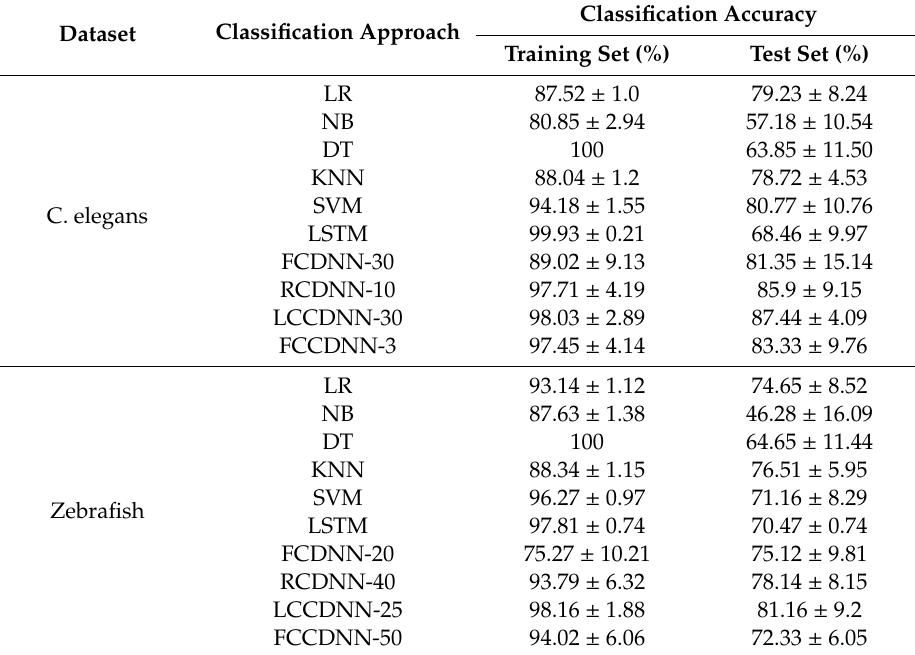
Table 3. Comparison of the accuracy of the